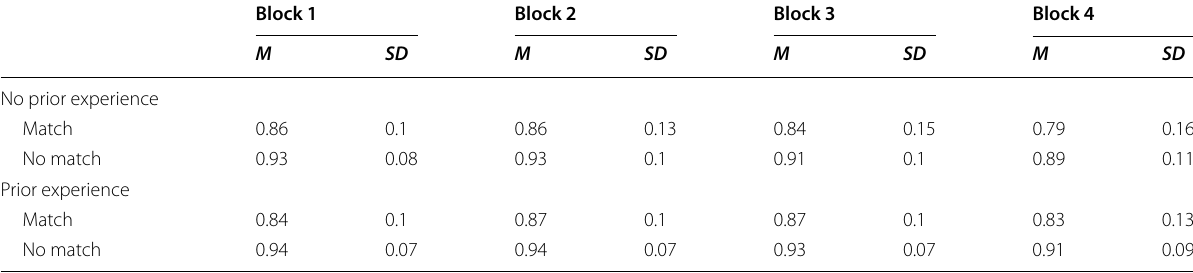
Table 1 Ongoing task accuracy across blocks by experience condition in Experiment